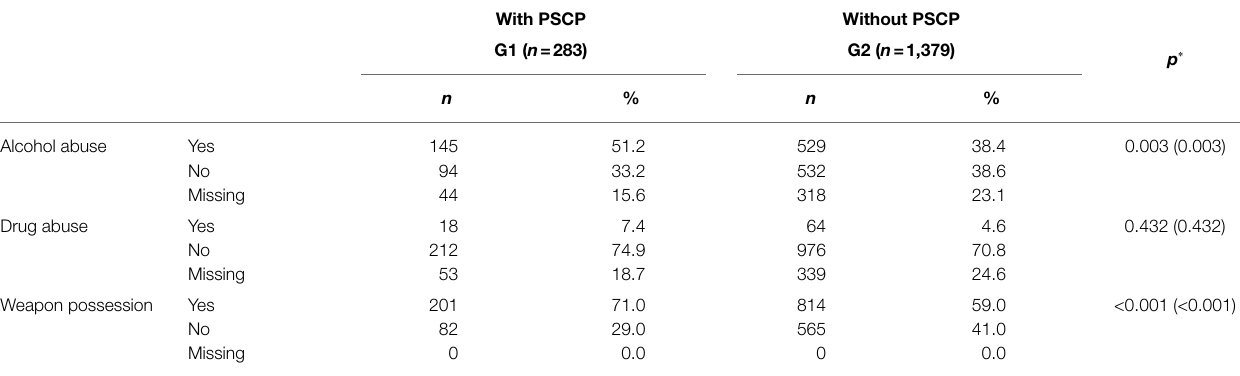
TABLE 2 | Defendants risk factors.